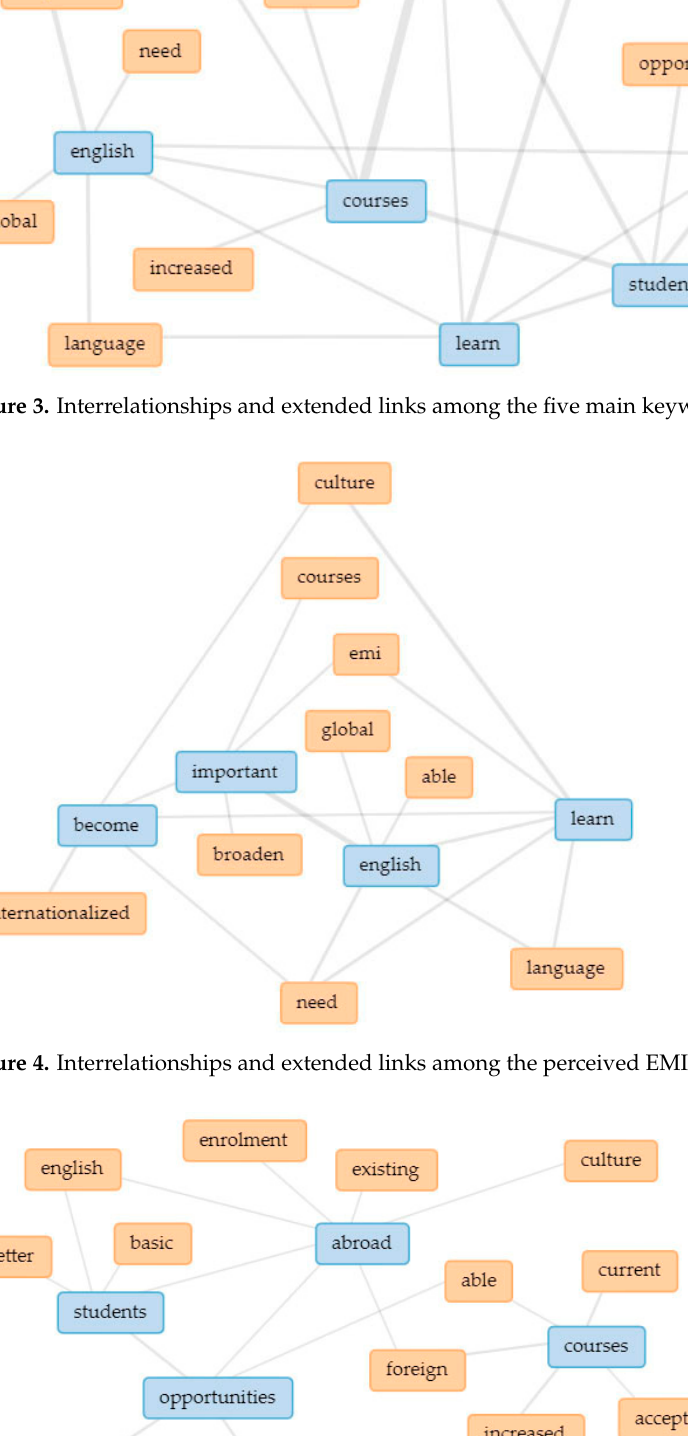
Figure 6. Interrelationships and extended links among the perceived EMI weakness. Figure 7. Interrelationships and extended links among the perceived EMI opportunities.